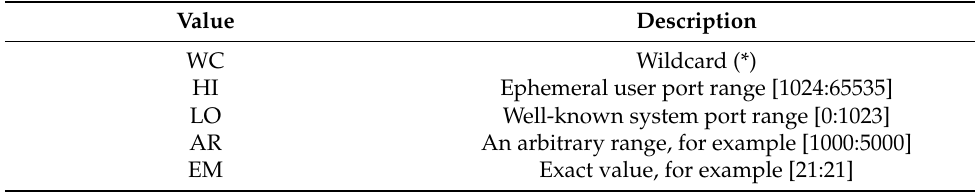
Table 4. Five classes of the source/destination port field.